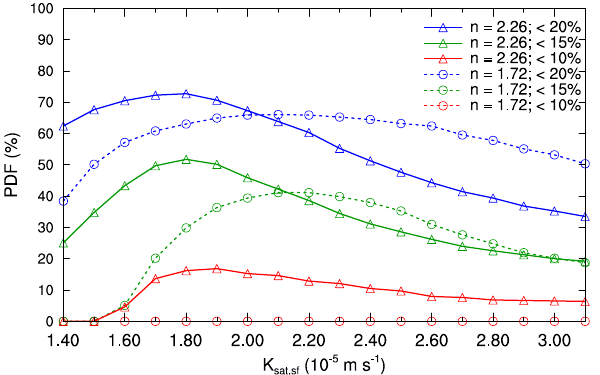
Figure 8. Probability density functions of best simulations for M3_Hetero ( n =1.72) and M4_Hetero ( n =2.26) simulations at var- ious error levels across the 18 K sat,sf values considered.